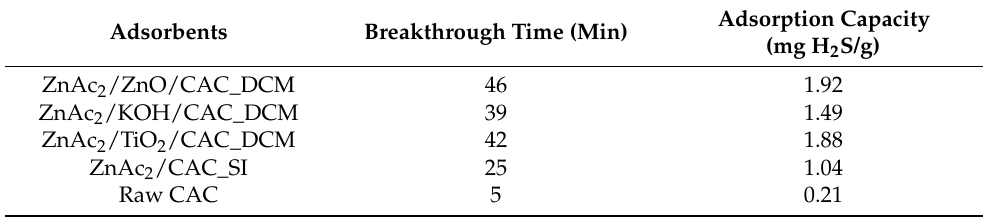
Figure 6. Relative concentrations of the H 2 S profile curve over time. Table 4. Adsorption performance with prepared adsorbents (DCM/CAC, SI/CAC, and raw